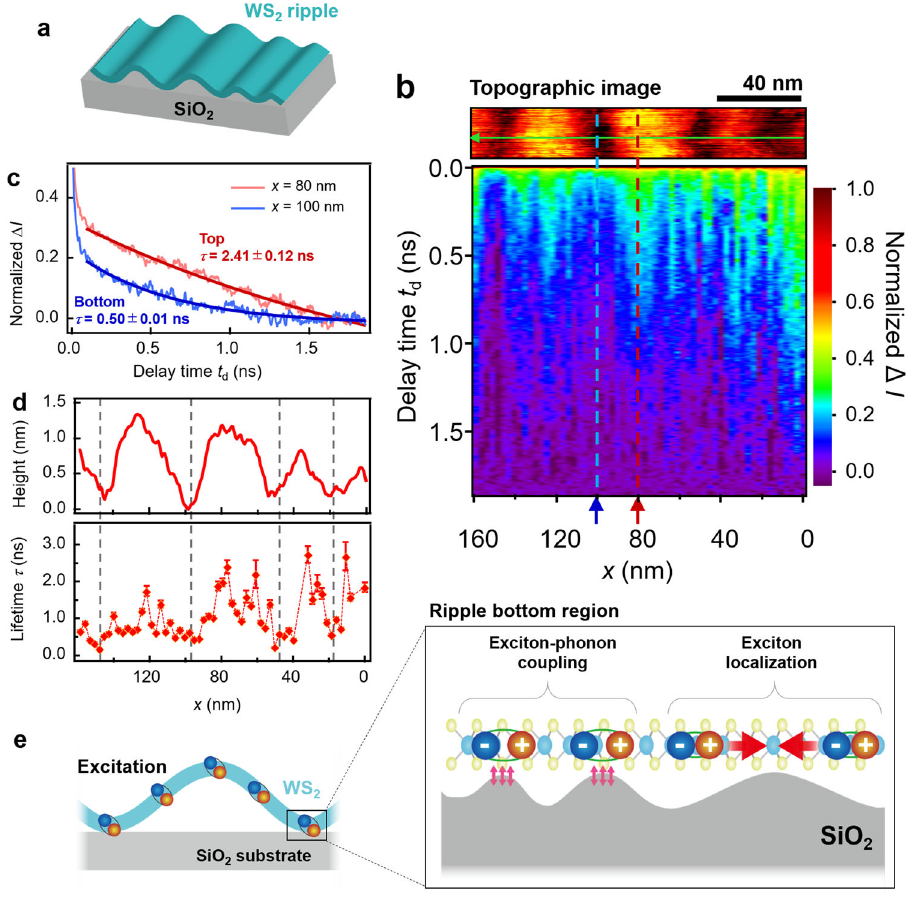
Fig. 5 TR-MP-STM measurement on ripple structure formed in WS 2 region. a Schematic of nanoscale ripple structure observed in Fig. 2c. V s = − 3.5 V, I set = 40 pA, f rep = 80 MHz, fl uence 13 μ J/cm 2 and center wavelength 633 nm. b STM image taken over a ripple area in WS 2 and the time-resolved signal acquired at the corresponding tip position on a color scale. c TR-MP-STM signal obtained along the red and blue lines in b . d Cross section along the green line in the STM image (upper fi gure in b ), and the variation in the time constant for the corresponding position (lower fi gure in b ). e Schematic diagram of the principle of spatially changing exciton dynamics. The error bars in d are the errors obtained with the fi tting shown in c